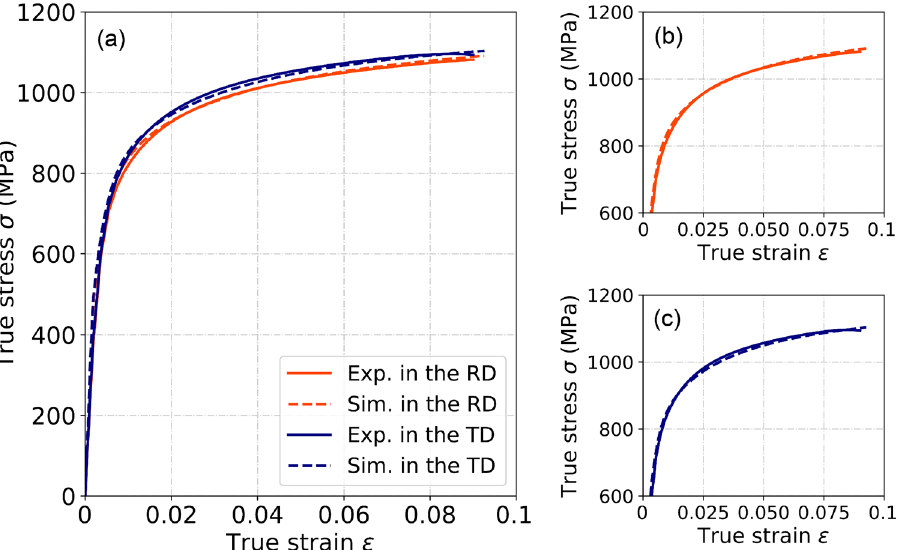
Figure 3. ( a ) Comparison of the flow stress curves predicted the calibrated CP model with the experimental ones along RD and TD. The partial magnifications of the results in RD and TD are shown in subfigures ( b ) and ( c ),